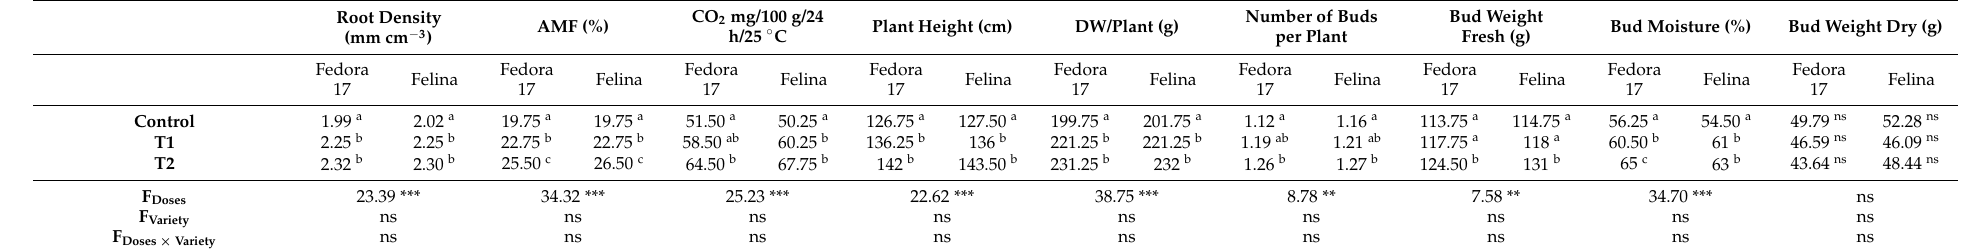
Table 3. Agronomic characteristics as affected by different treatments of Trichoderma harzianum in hemp varieties, Fedora 17 and